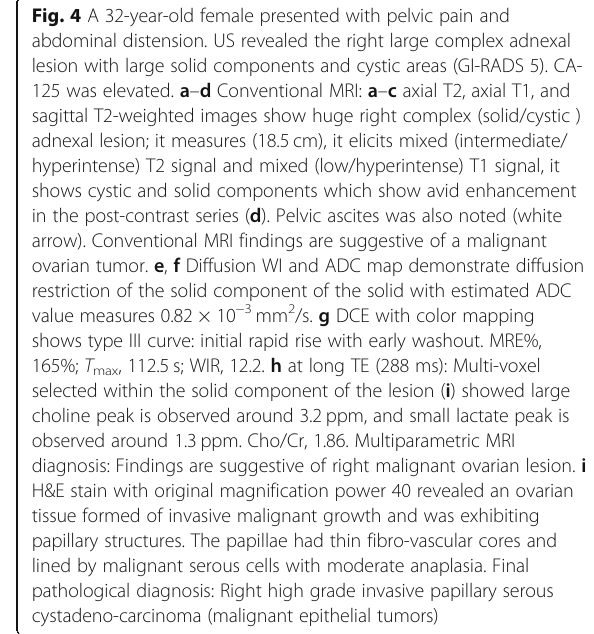
Fig. 4 A 32-year-old female presented with pelvic pain and abdominal distension. US revealed the right large complex adnexal lesion with large solid components and cystic areas (GI-RADS 5). CA- 125 was elevated. a – d Conventional MRI: a – c axial T2, axial T1, and sagittal T2-weighted images show huge right complex (solid/cystic ) adnexal lesion; it measures (18.5 cm), it elicits mixed (intermediate/ hyperintense) T2 signal and mixed (low/hyperintense) T1 signal, it shows cystic and solid components which show avid enhancement in the post-contrast series ( d ). Pelvic ascites was also noted (white arrow). Conventional MRI findings are suggestive of a malignant ovarian tumor. e , f Diffusion WI and ADC map demonstrate diffusion restriction of the solid component of the solid with estimated ADC value measures 0.82 × 10 − 3 mm 2 /s. g DCE with color mapping shows type III curve: initial rapid rise with early washout. MRE%, 165%; T max , 112.5 s; WIR, 12.2. h at long TE (288 ms): Multi-voxel selected within the solid component of the lesion ( i ) showed large choline peak is observed around 3.2 ppm, and small lactate peak is observed around 1.3 ppm. Cho/Cr, 1.86. Multiparametric MRI diagnosis: Findings are suggestive of right malignant ovarian lesion. i tissue formed of invasive malignant growth and was exhibiting papillary structures. The papillae had thin fibro-vascular cores